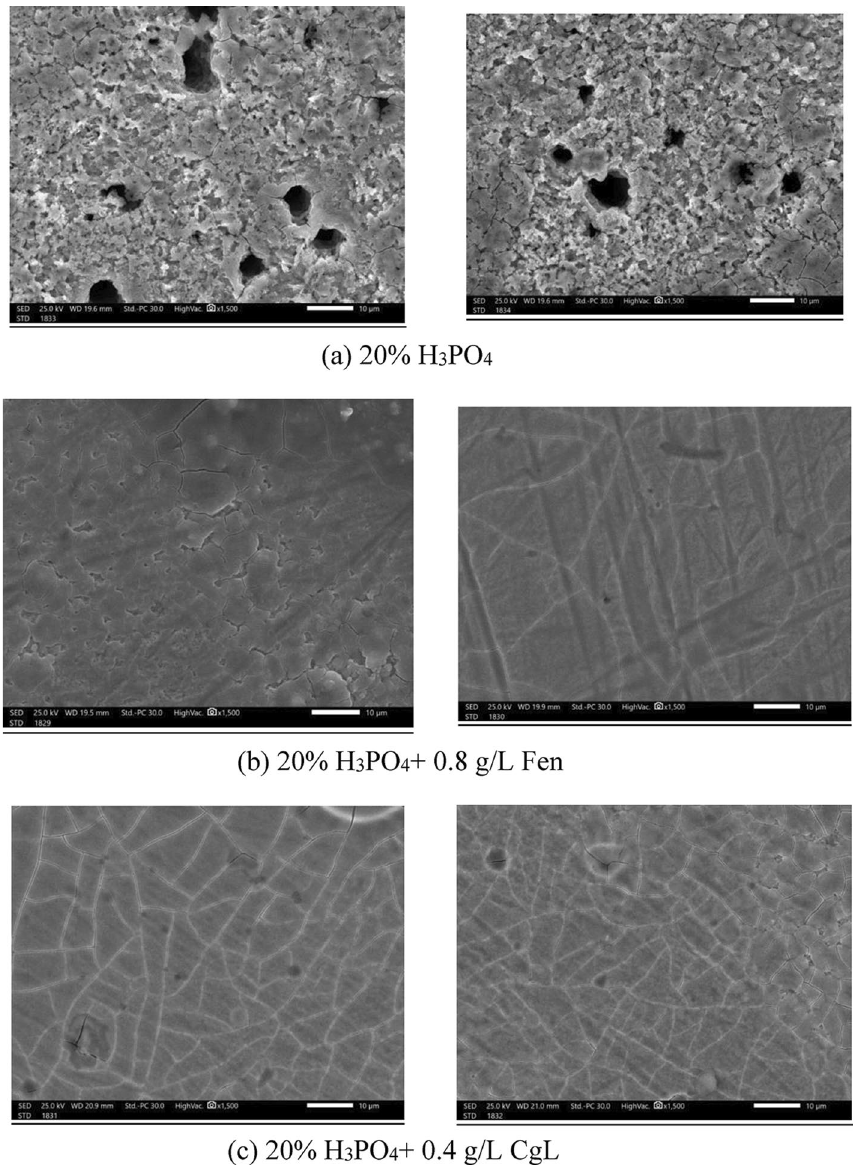
Figure 11. SEM micrograph of steel in the presence and absence of 0.8 g/L Fen and 0.4 g/L CgL